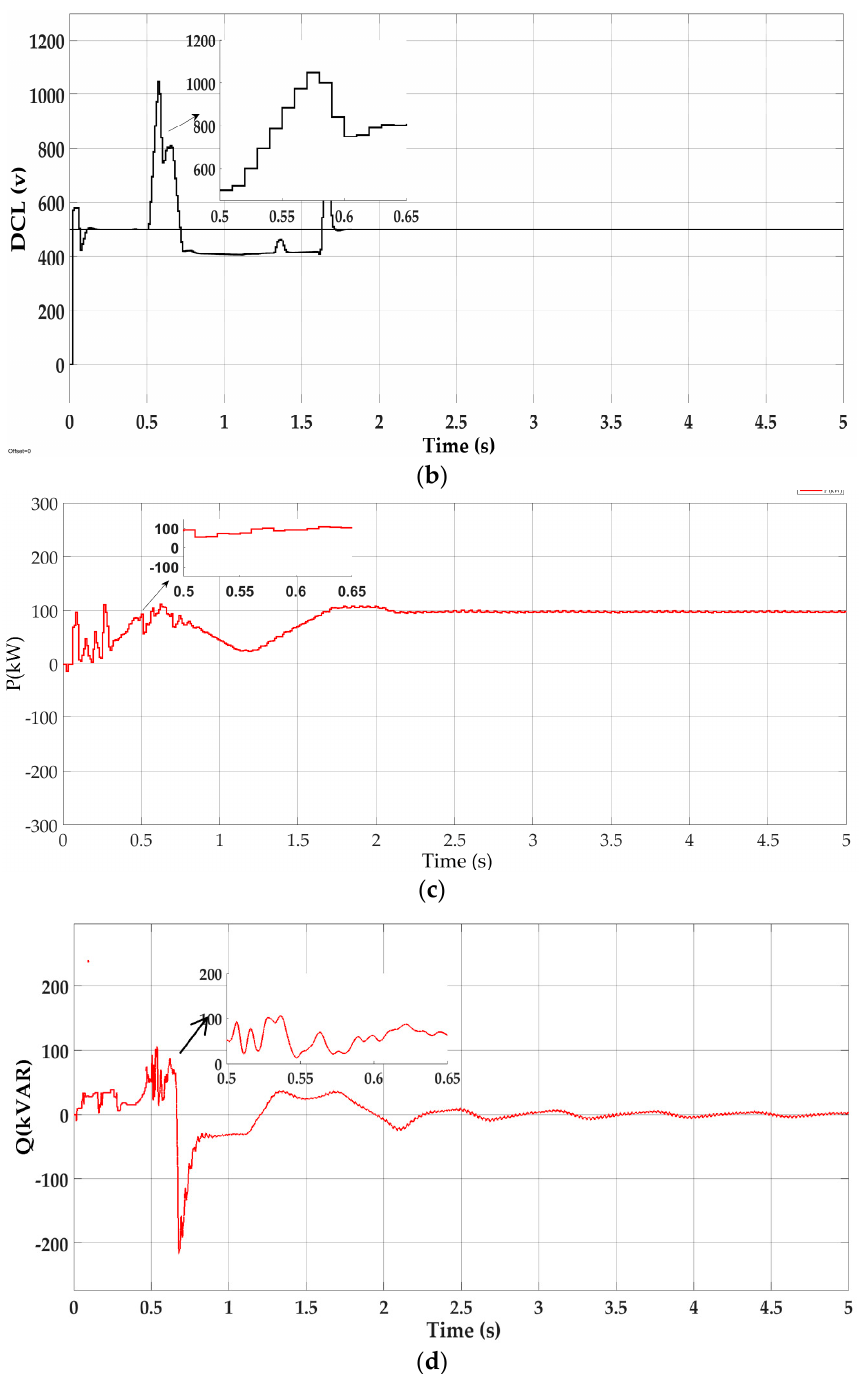
Figure 11. Simulation results of the MPPT control scheme under an asymmetrical fault (1LG). ( a ) Grid voltage at PCC, ( b ) DC-link voltage (DCL), ( c ) active power (P), ( d ) reactive power (Q).